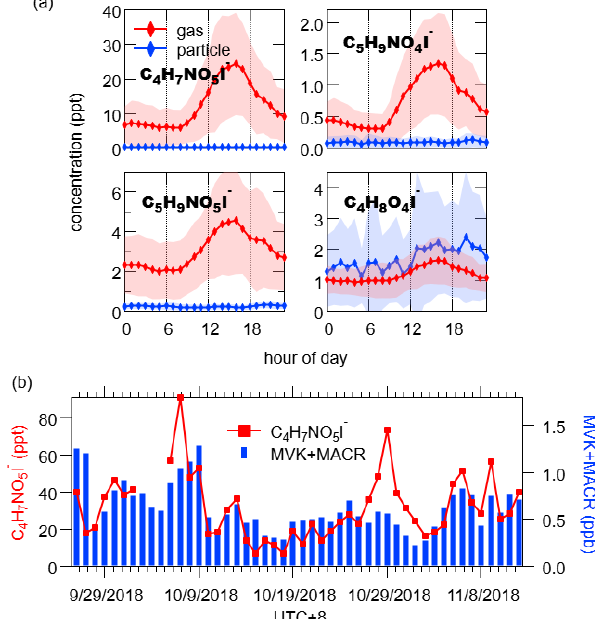
Figure 8. (a) Diurnal variations of isoprene oxidation products in the gas phase (red) and particle phase (blue). The shaded area indicates 1 standard deviation. (b) Time series of daily maxi- mum concentrations of gaseous C 4 H 7 NO 5 I − and MVK + MACR (C 4 H 6 OH + , m/z 71.05) measured by PTR-ToF-MS.